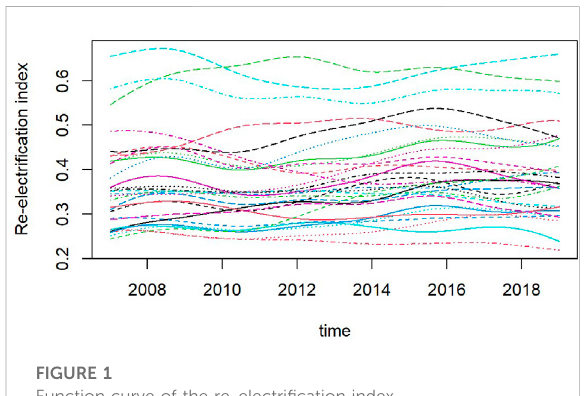
FIGURE 1 Function curve of the re-electri fi cation